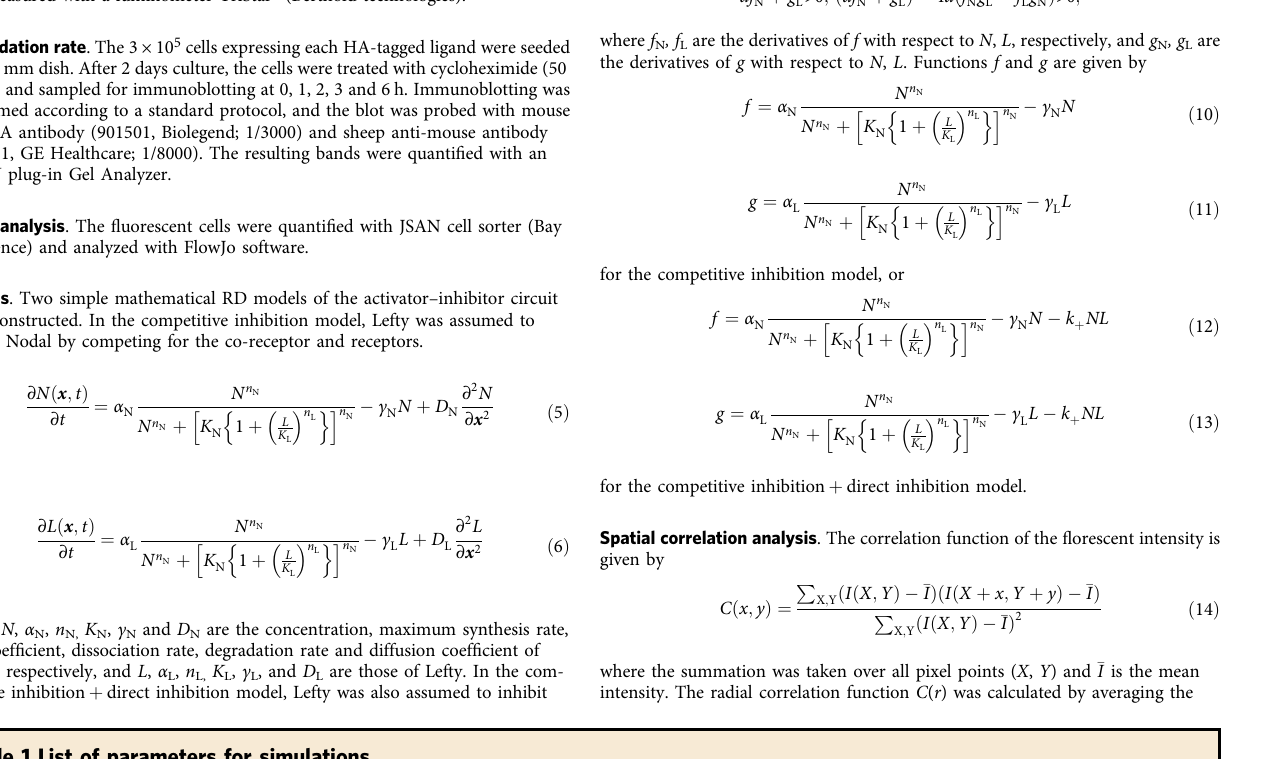
Table 1 List of parameters for simulations